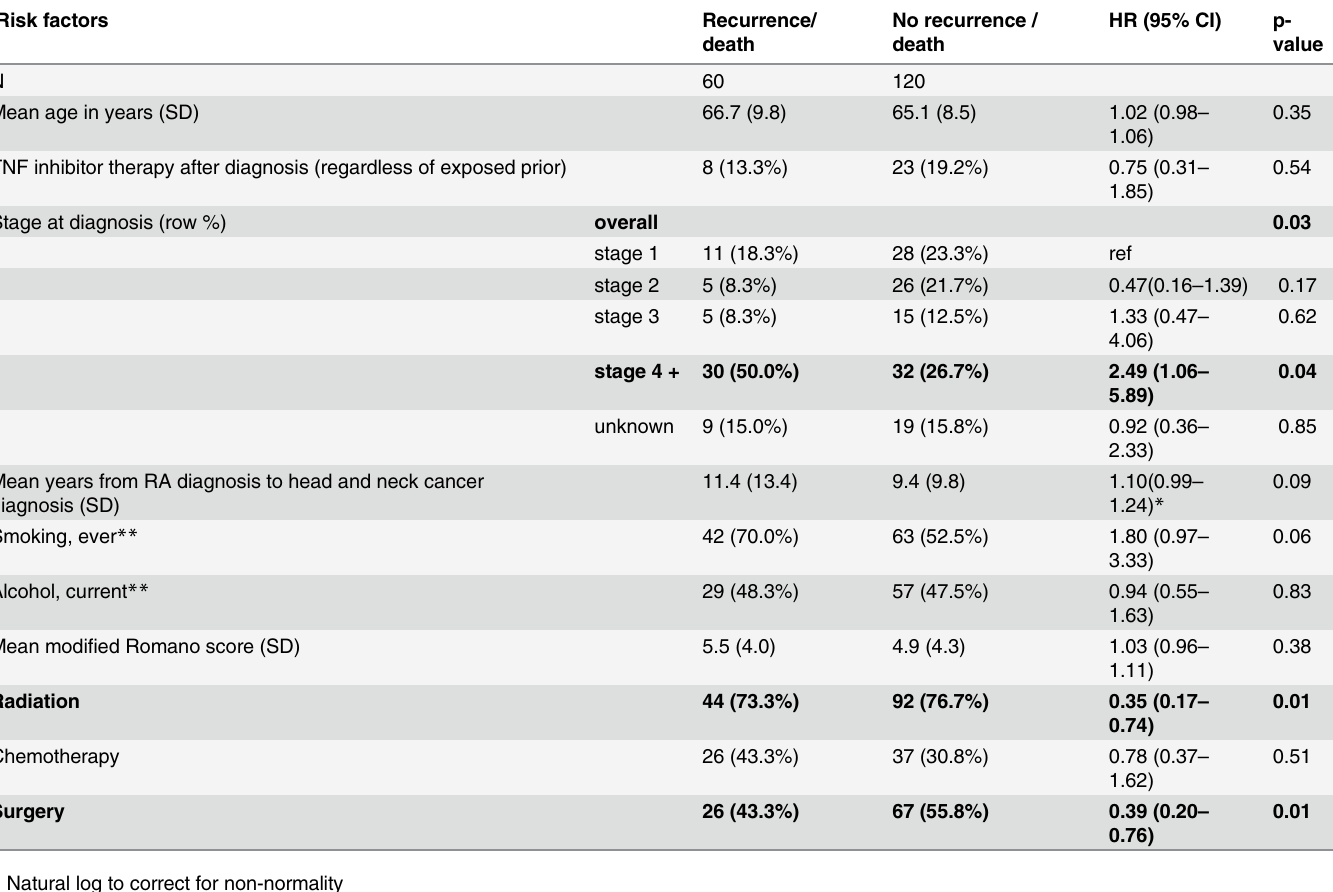
When subjects with evaluable stage were grouped by early (stage 1 and 2) and late (stage 3+) disease, those who received TNFi at any time (before or after HNC diagnosis) had a similar unadjusted rate of HNC recurrence or HNC-attributable death to those who only received nbDMARDs for early stage HNC (3/18, [17%] vs 14/52 [27%], p = 0.38), and significantly lower rate of unadjusted HNC recurrence or HNC-attributable death among those with late stage HNC (4/24, [17%] vs 27/60, [45%], p = 0.02). However, exposure to TNFi was not associ- ated with either risk or protection from HNC recurrence or HNC-attributable death in our multivariate model as described above. Table 3. Risk factors for head and neck cancer recurrence or HNC-attributable death in multivariate